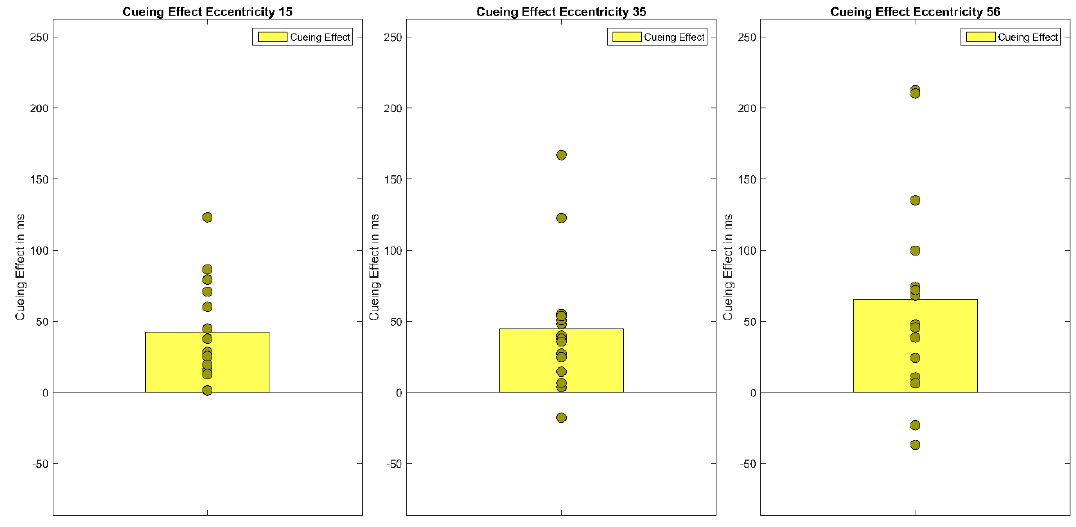
Figure 6. The figure shows Experiment 2 ′ s cueing effects (invalid RT-valid RT) for each eccentricity (15°, 35°, 56°). Bars show the mean of cueing effects across participants. Filled circles show the cueing effects of each individual participant. A two-way ANOVA of arcsine-transformed percent correct data with factors Cueing × Eccentricity revealed only a main e ff ect of Eccentricity, F (1.29,18.05) = 57.45, p < 0.001, η 2 G = 0.43. This main e ff